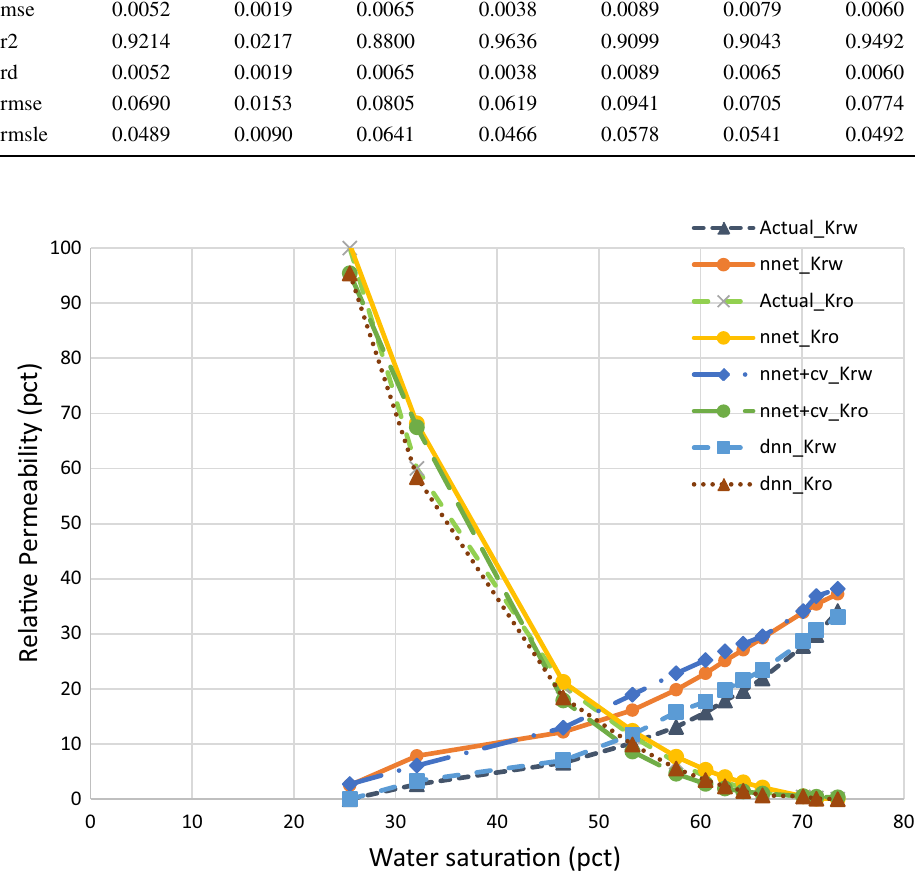
Table 4 Accuracy of the deep learning model for the non-wetting phase with cross validation for the fivefolds